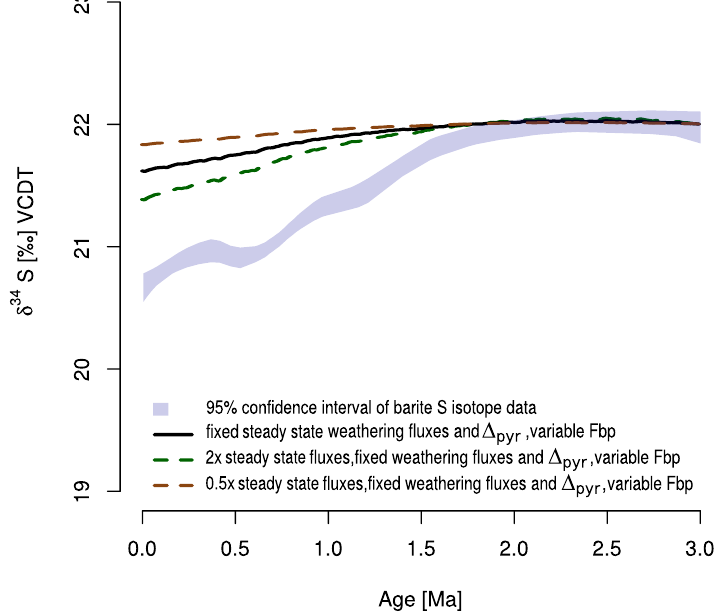
Figure A2. Model output with variable pyrite burial and fixed weathering fluxes and (cid:49) pyr . Black solid line – model output produced assuming initial fluxes at steady state values, variable pyrite burial and fixed weathering fluxes and (cid:49) pyr . Green dashed line – model output produced assuming initial fluxes at 200% steady state values, variable pyrite burial and fixed weathering fluxes and (cid:49) pyr . Brown dashed line – model output produced assuming initial fluxes at 50% steady state values, variable pyrite burial, fixed weathering fluxes and (cid:49) pyr . The shaded area represents the 95% confidence interval of a LOESS approximation of the “true” δ 34 S SO 4